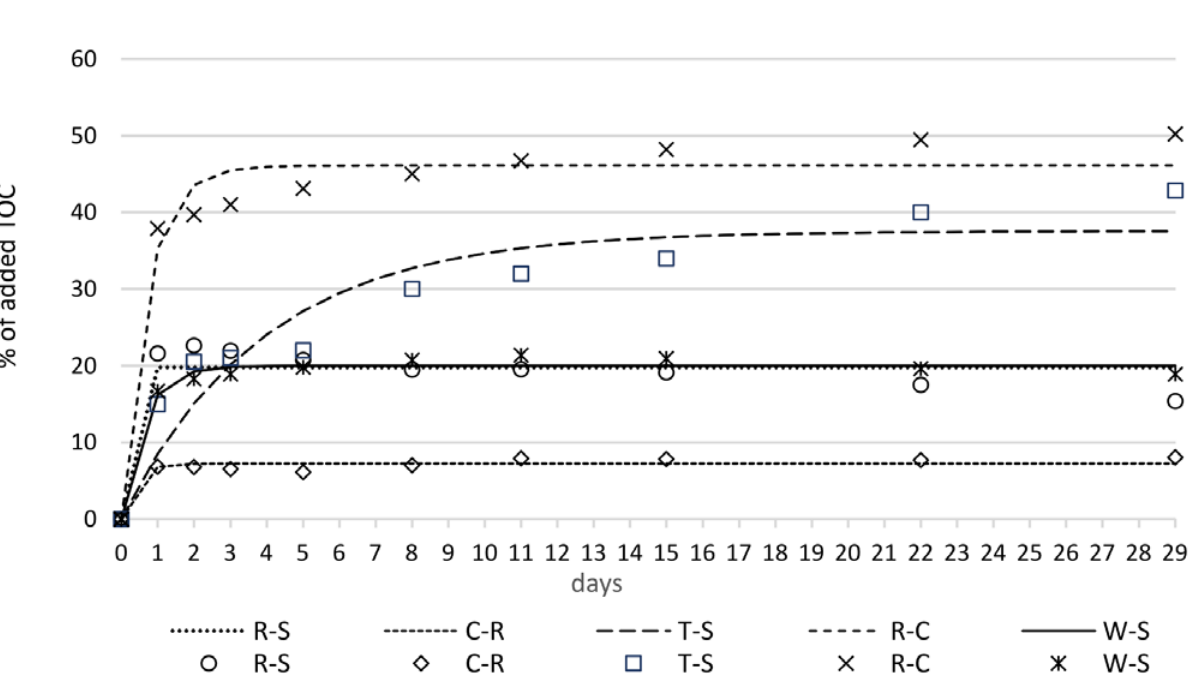
Figure 4. Cumulative mineralised-C from the amended soils (dots are experimental data and lines represent the curve-fitting). Amendments: R-S = Reed sweet-grass digestate, C-R = Common reed digestate, T-S = Tufted sedge digestate, R-C = Reed canary grass digestate, W-S = Woollyfruit sedge